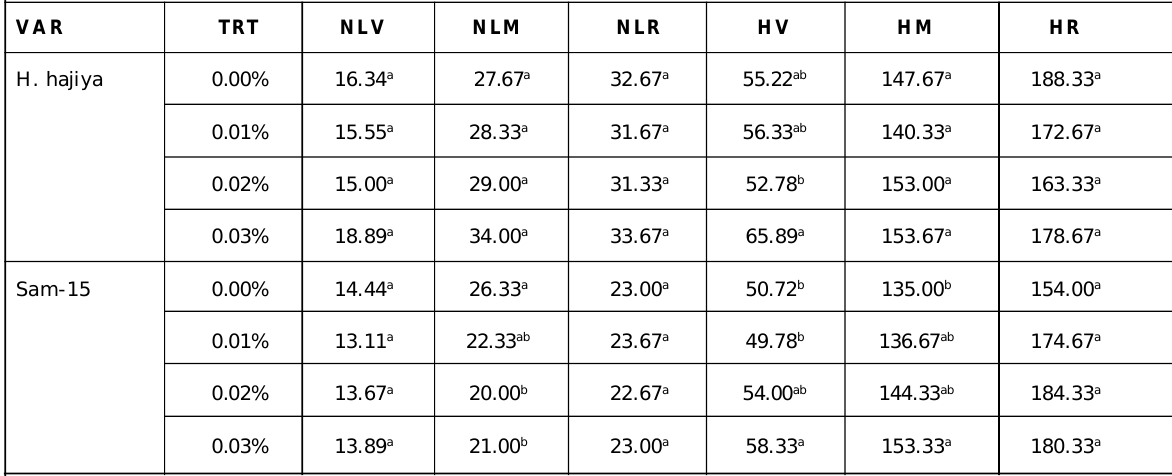
Table 2: Effects of sodium azide on some growth parameters VAR TRT NLV NLM NLR HV HM HR